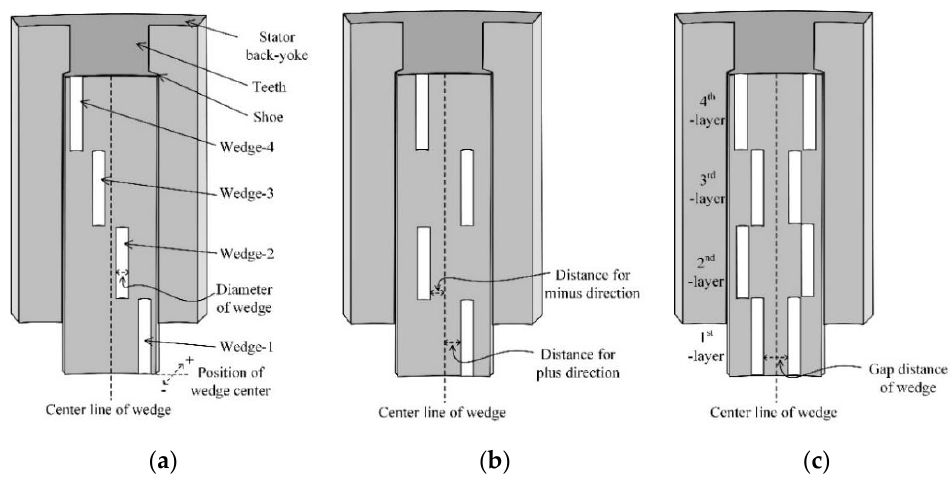
Figure 9. Schematic of the wedge skew: ( a ) A-type; ( b ) B-type; ( c )